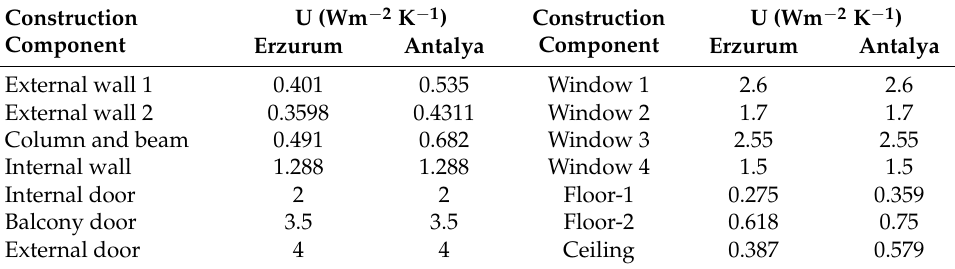
Table 5. Thermal transmittance coefficients of construction